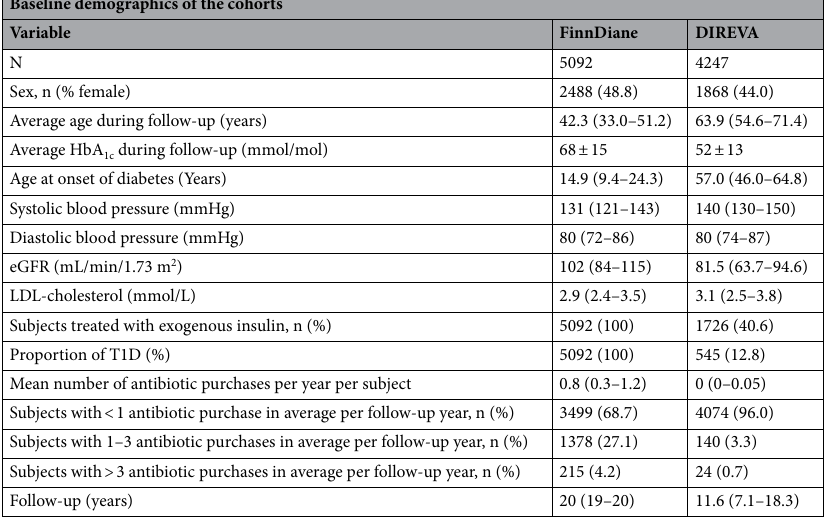
Table 1. Clinical characteristics of the individuals in the FinnDiane and DIREVA-cohorts. Data is presented as means ± SD, median (IQR) or number (percentages) where appropriate. In the DIREVA-cohort, data on blood pressure was available for 3231 individuals. HbA 1c glycated hemoglobin, eGFR estimated glomerular filtration rate, LDL low-density lipoprotein, T1D type 1